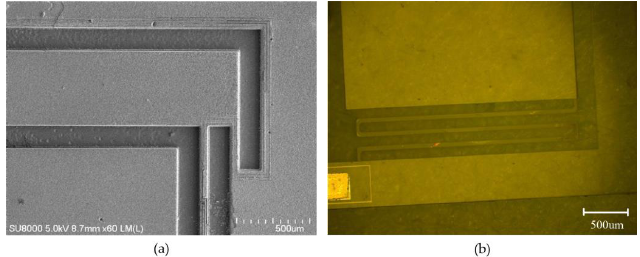
Figure 16. ( a ) SEM picture of the etched quartz structure; ( b ) the picture of the etched quartz structure under a light microscope.